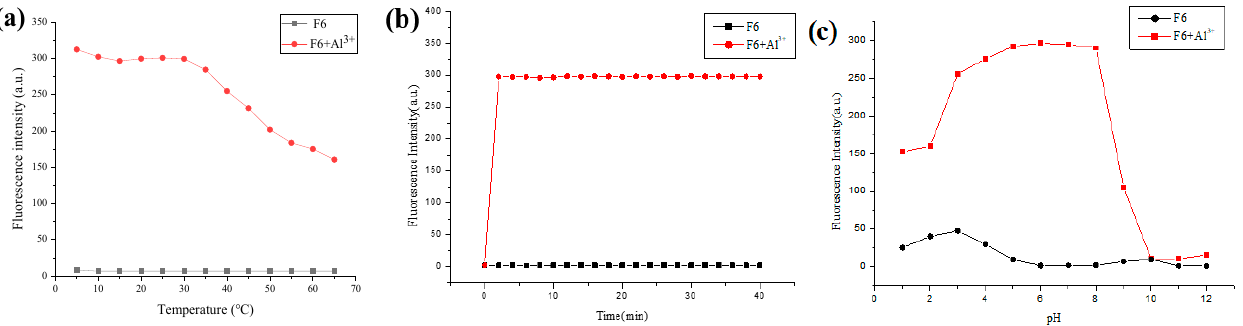
Figure 6. Effect of reaction temperature ( a ), reaction time ( b ), different pH ( c ) on the fluorescence system.